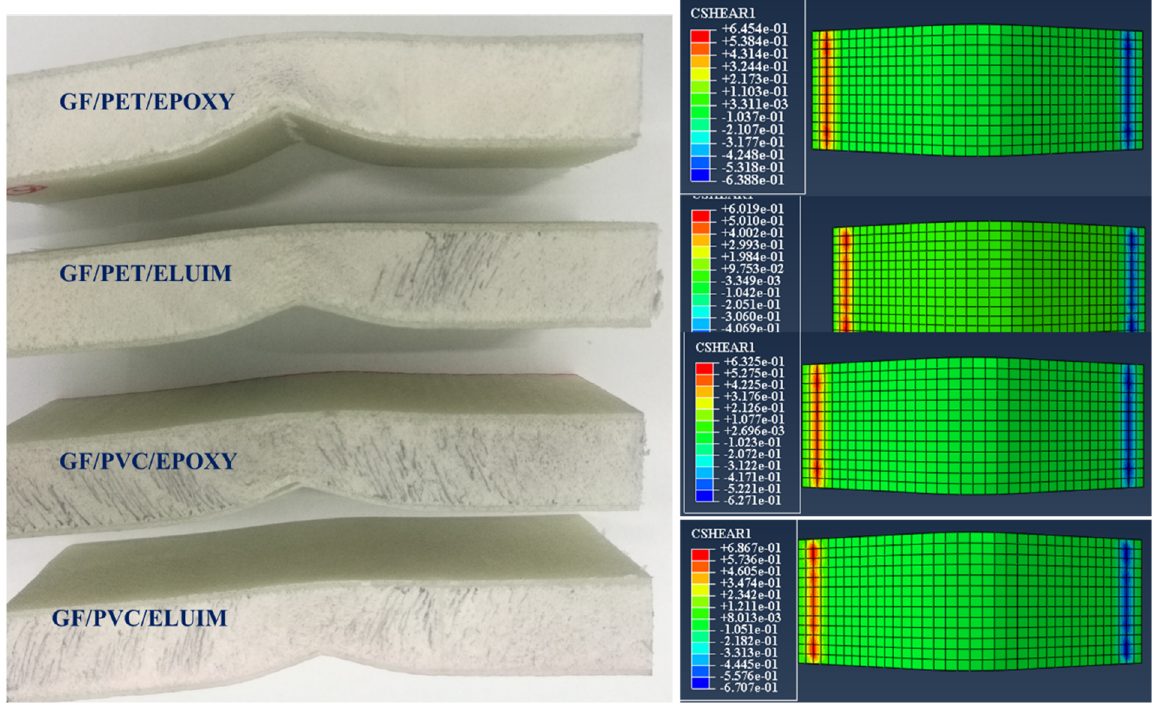
Figure 10. Experimental and simulation damage of the GFRP sandwich composites’ lower face sheets.